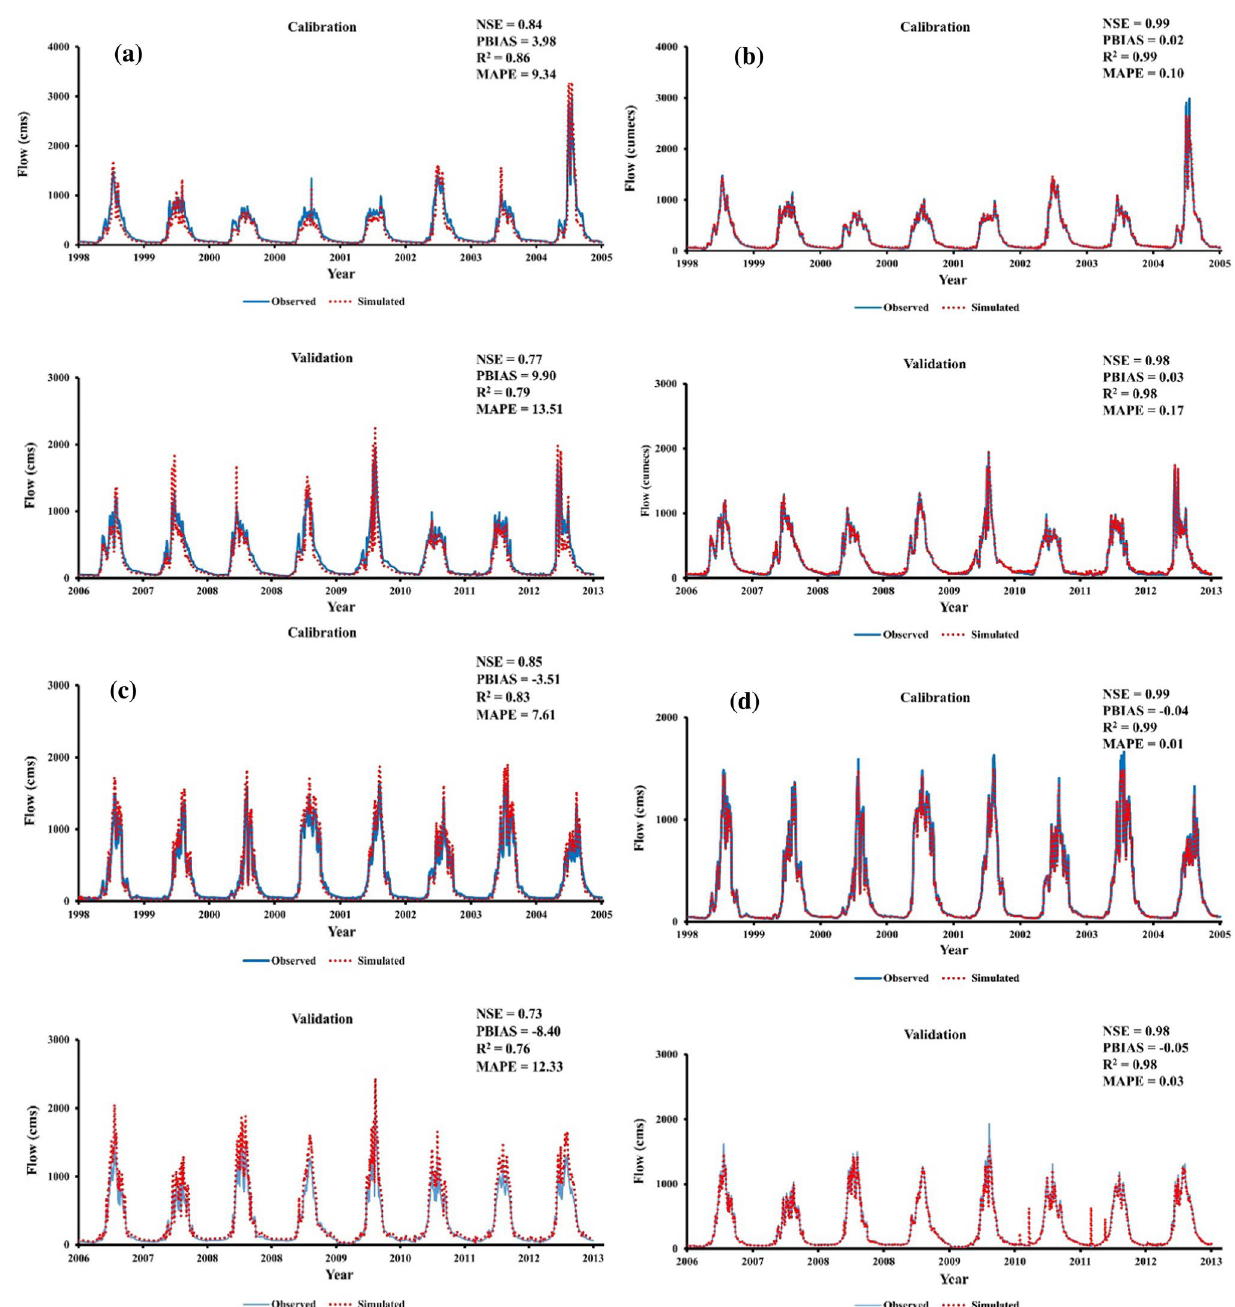
Fig. 5 Comparison of streamflow simulated by SWAT (left panel) across a Gilgit and c Hunza sub-basins with MLP (right panel) across b Gilgit and d Hunza